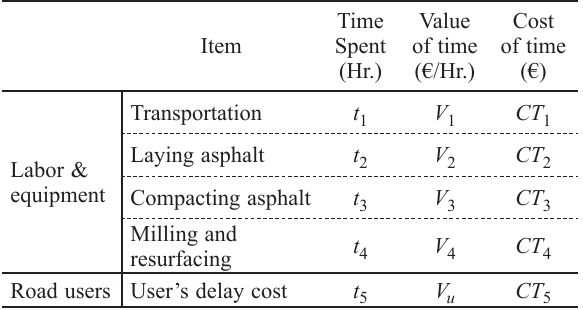
Table 2. Time related variables Item